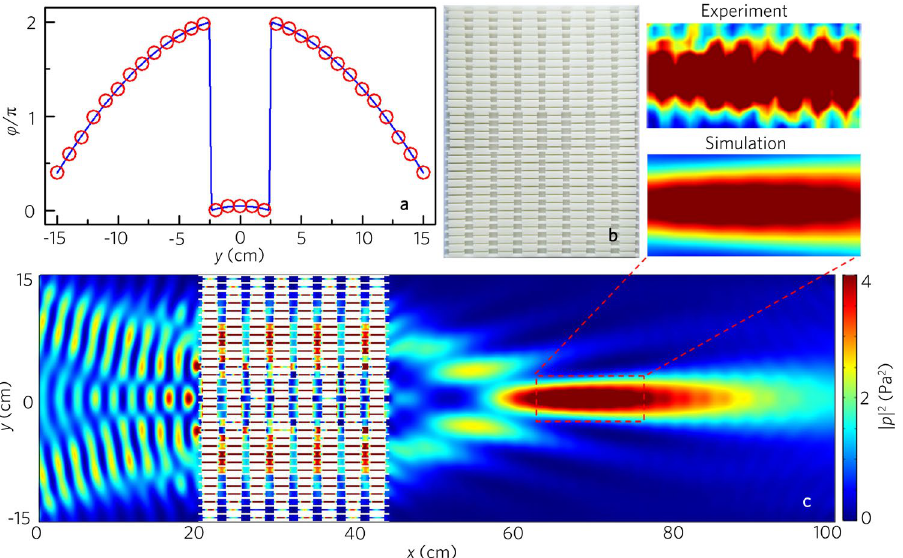
Figure 9. Acoustic focusing. ( a ) Distribution of thirty-one acoustic metafibers along y direction as indicated by their discrete phase shift (thirty-one red hollow dots) resembling the desired phase profile ϕ ( y ) (blue line). ( b ) Photograph of the designed focusing lens. ( c ) Simulated and measured acoustic pressure field distributions with the acoustic focusing lens illuminated by the normally incident plane wave at 8.0